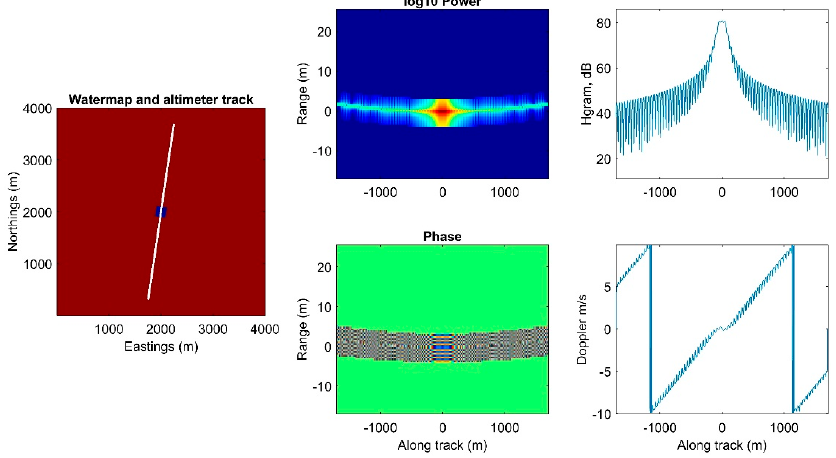
Figure 4. Model for the square lake example (dimensions are approximately 200 m × 200 m).